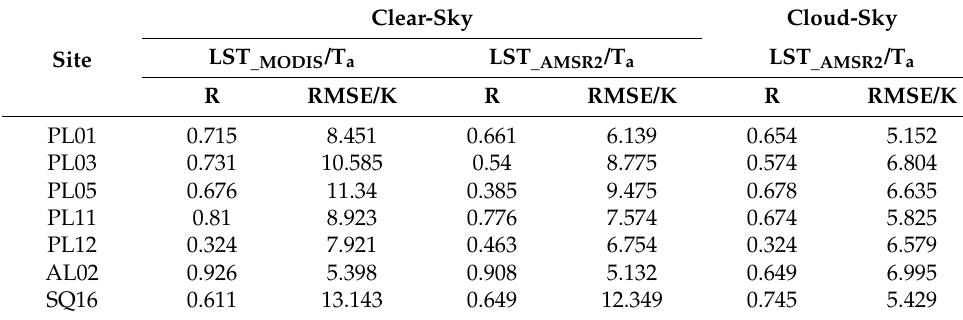
Table 5. R and RMSE between predicted LST and soil